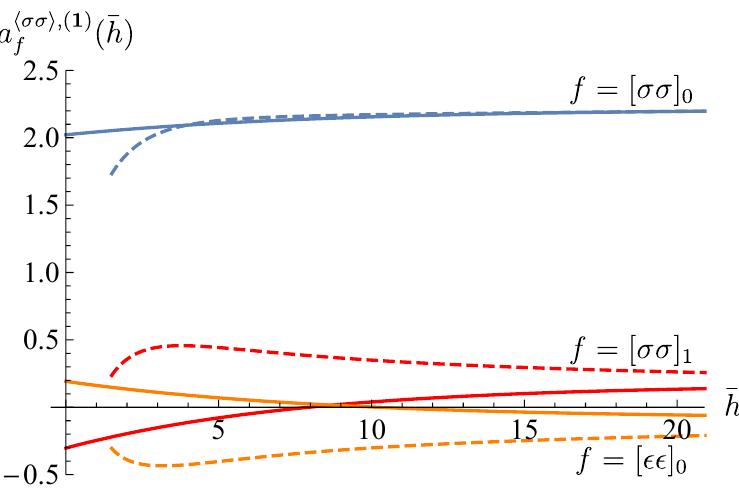
Figure 11. The e(cid:11)ect of operator mixing for the thermal coe(cid:14)cients in the [ (cid:27)(cid:27) ] 0 , [ (cid:27)(cid:27) ] 1 , and [ (cid:15)(cid:15) ] 0 families. As an example we show the coe(cid:14)cient of a h (cid:27)(cid:27) i